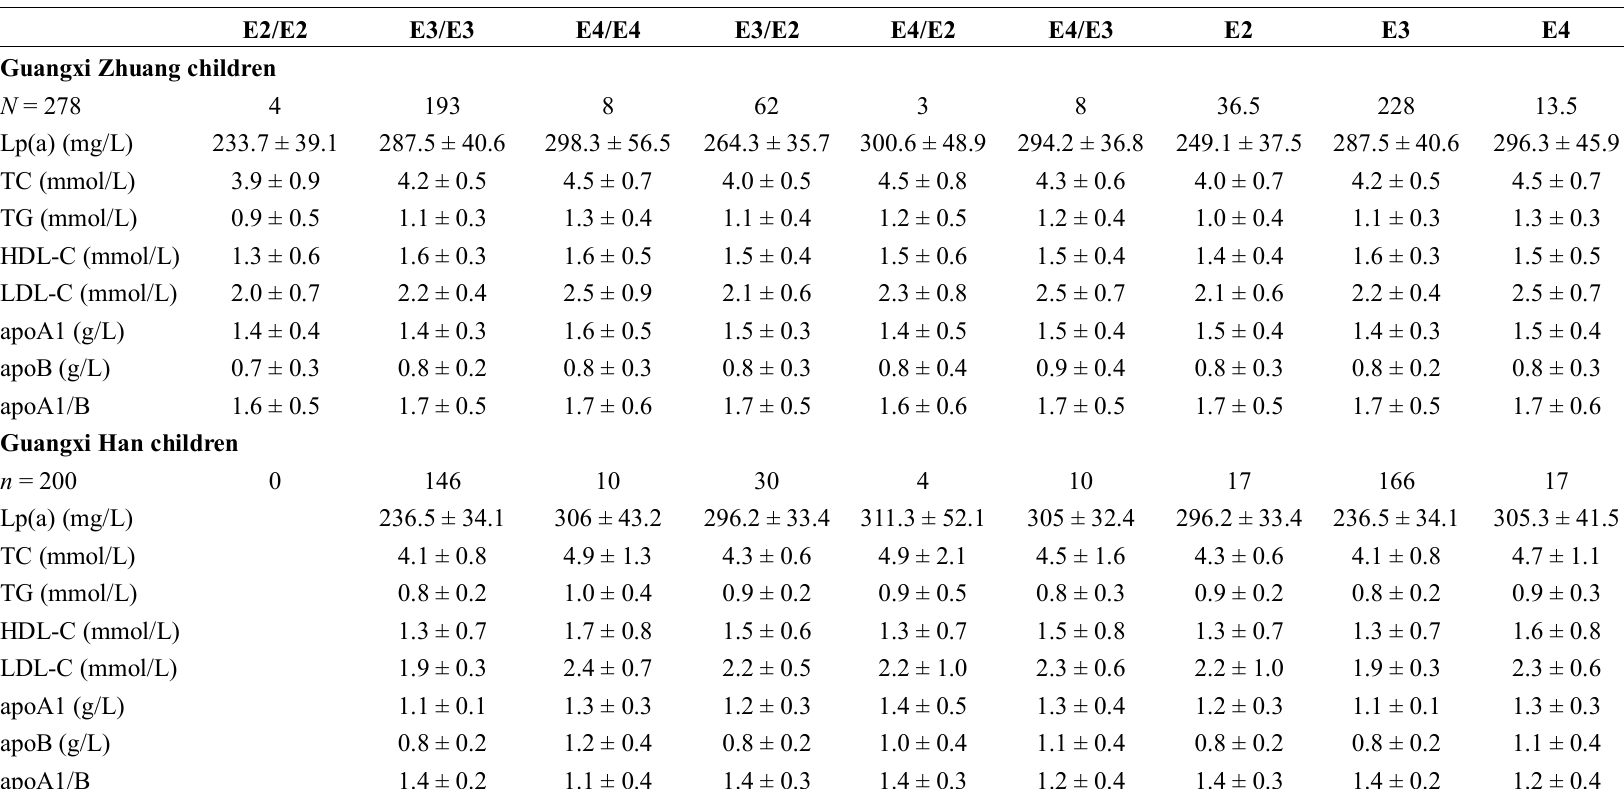
Table 3. The influences of APOE genotypes and alleles on serum lipid concentrations in the Guangxi Zhuang and Han